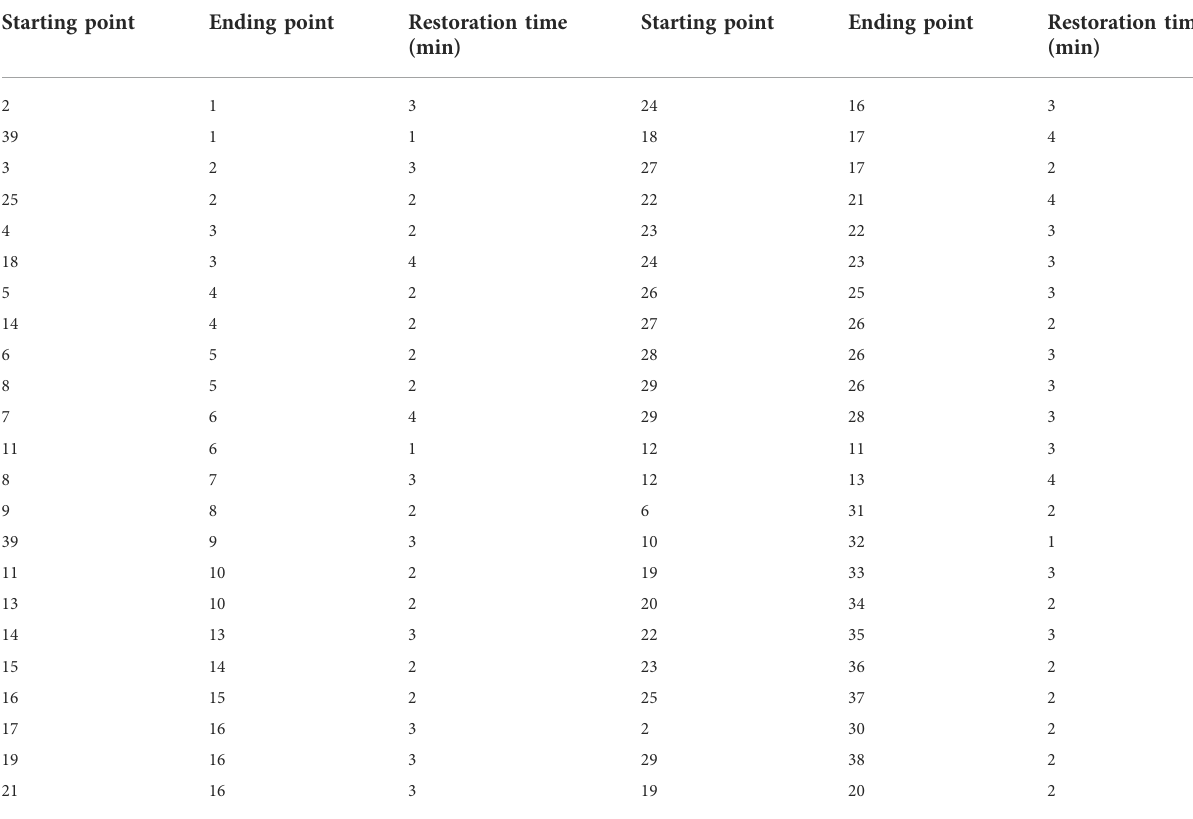
TABLE 2 The restoration time of transmission